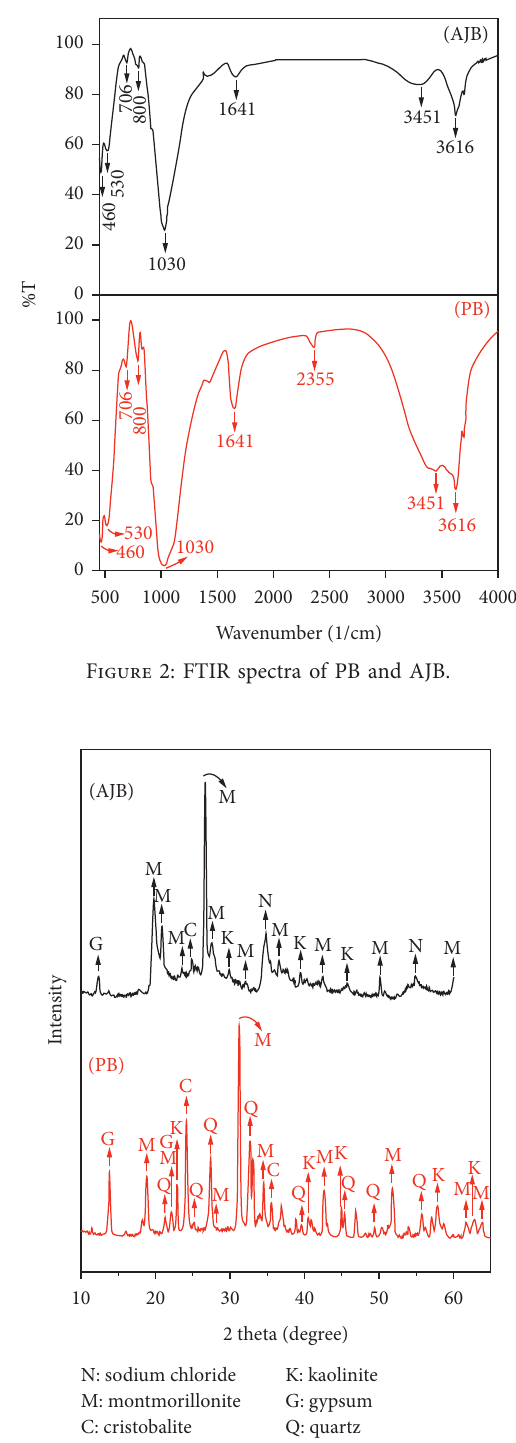
Figure 3: X-ray diffraction patterns of the PB and